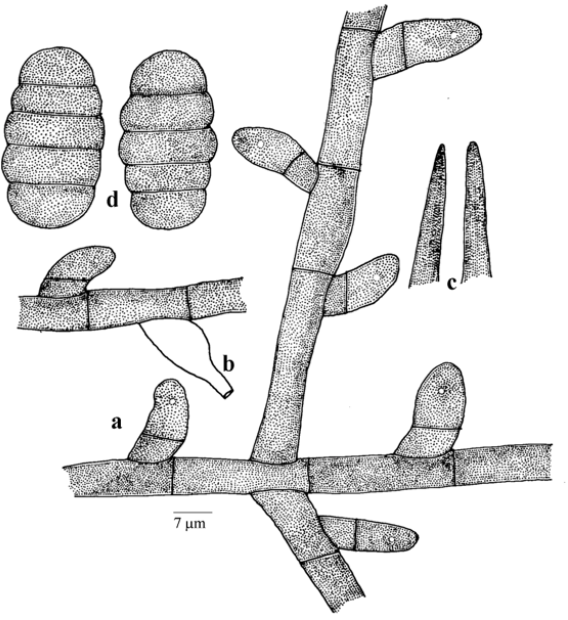
Figure 36. Meliola affinis var. indica a - Appressorium; b - Phialide; c - Apical portion of mycelial setae; d -